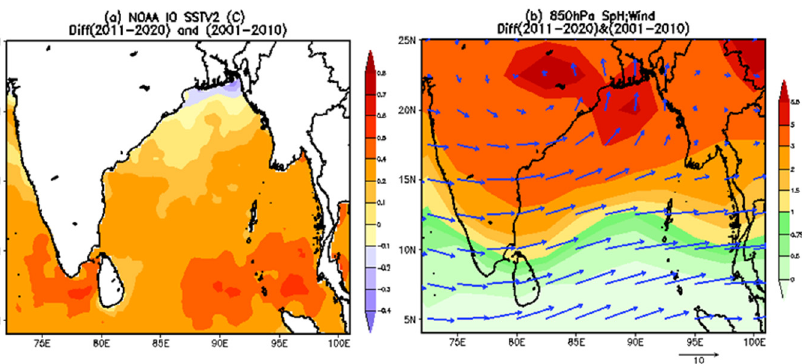
Figure 14. Variations of cyclone related variables over the BoB: ( a ) difference in SST (°C) and ( b ) specific humidity (shaded; gm·Kg − 1 ), along with wind field (ms − 1 ) at 850 hPa level during two recent decades 2011–2020 and 2001–2010, derived from NOAA reanalysis. Table 6. Decadal variability in the number of tropical storms over the Bay of Bengal during the